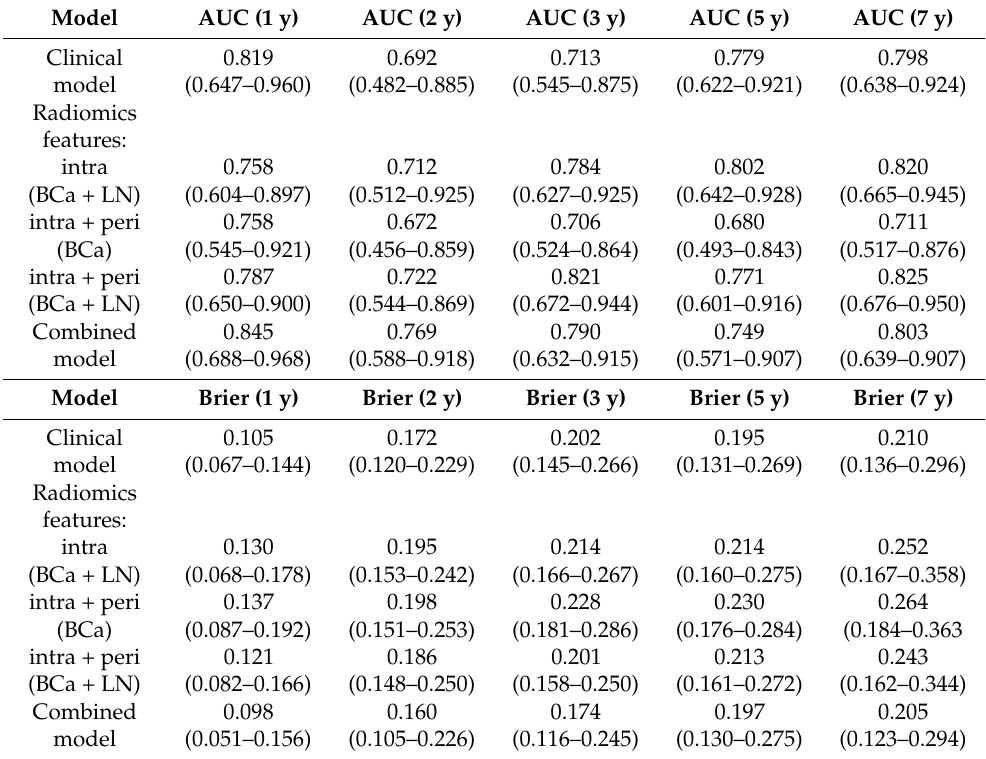
Figure 3. Time-dependent AUC was measured over the period from 1 to 7 years at 1-month intervals, reflecting the performance of predicting overall survival at different time points. The blue line corresponds to the model using radiomics features, and the orange line corresponds to the clinical model. The dotted lines correspond to the mean AUC over the presented time range. Table 3. Results of the analysis in terms of AUC and Brier score, measured at 1, 2, 3, 5 and 7 years after